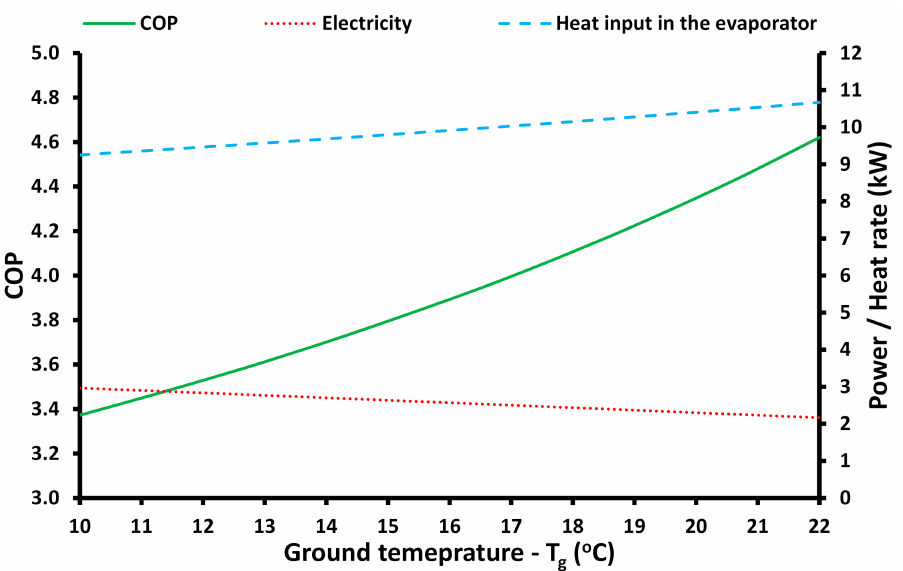
Figure 14. The impact of the ground temperature in the evaporator on the COP, electricity consump- tion and heat input in the evaporator.